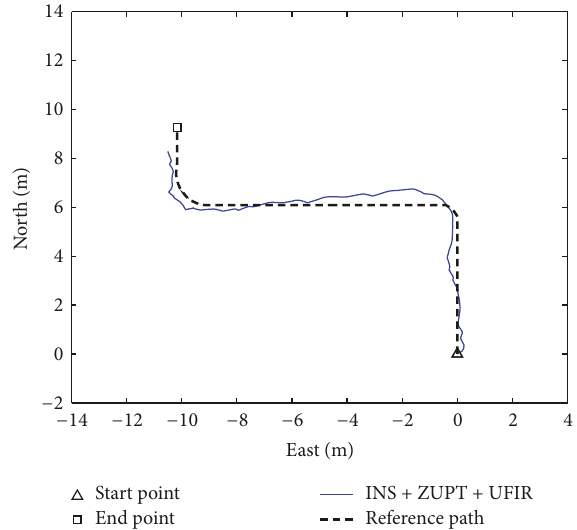
Figure 4: Trajectory measured by INS + ZUPT + UFIR for the first group of possible parameters (Group